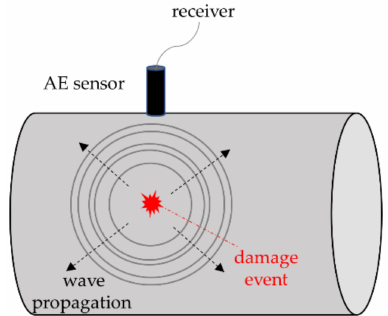
Figure 11. The basic concept of AE event